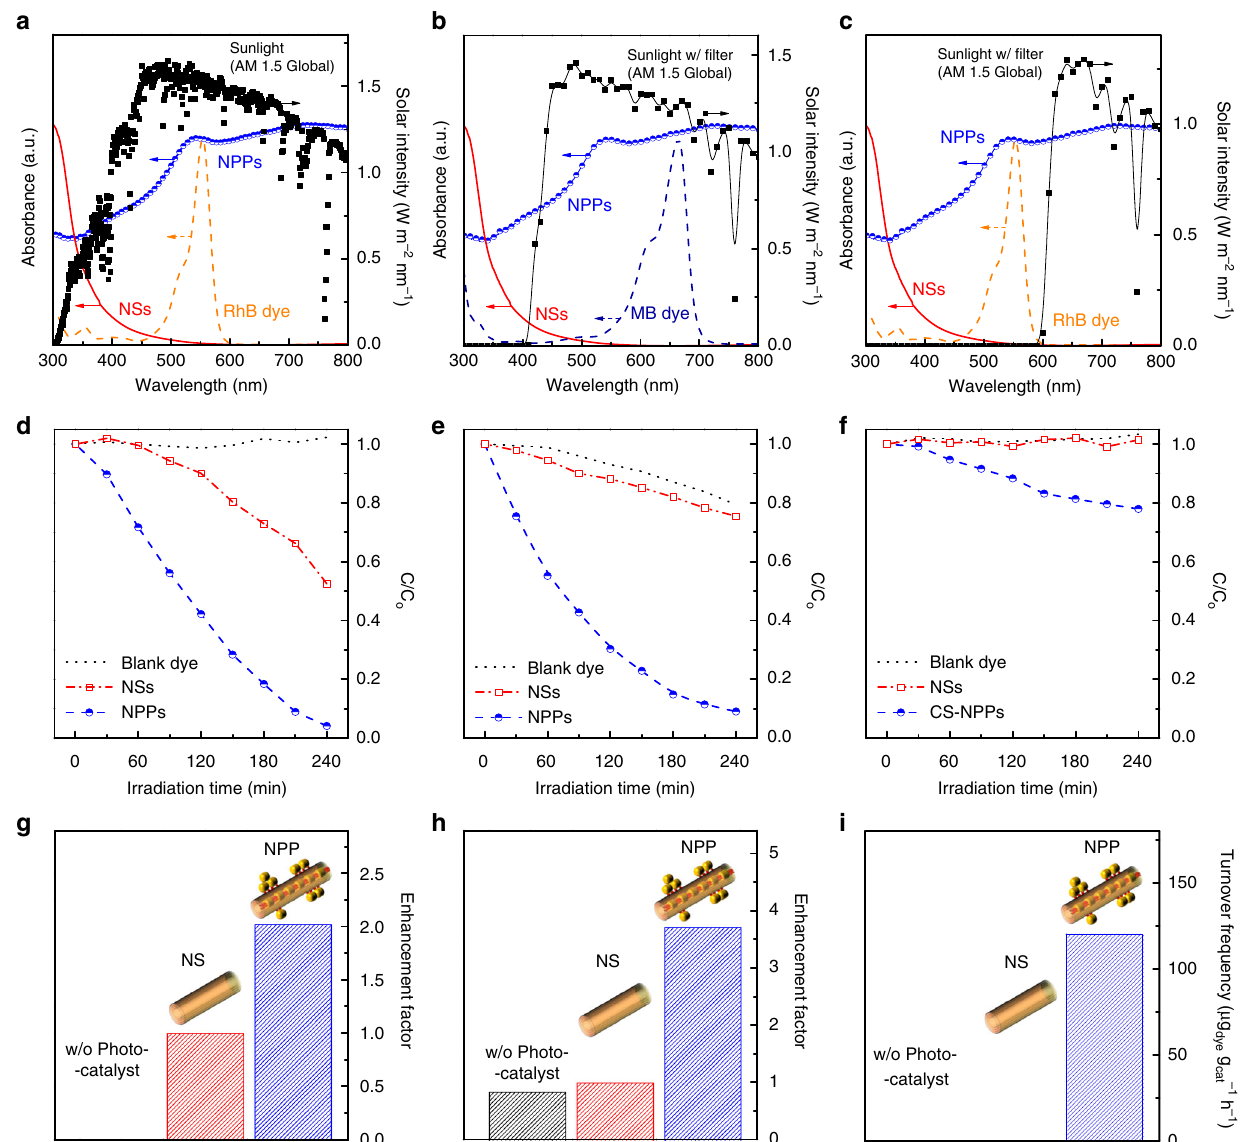
Fig. 3 Broadband photocatalytic activity of the Au@Nb@H x K 1 − x NbO 3 NPPs. a – c Spectra of simulated sunlight ( a ) further equipped with either an UV cutoff fi lter ( b ) or a colored glass fi lter ( c ) that work as irradiation sources for photocatalytic dye degradation. Absorption spectra of the employed H x K NSs (solid line) and the Au@Nb@H x K 1 − x NbO 3 NPPs (half- fi lled circles) as photocatalysts; methylene blue (MB) and rhodamine B (RhB) as probing species (dashed line) are plotted alongside for reference. d – f Photocatalytic decoloring of RhB ( d , f ), and MB ( e ) in the absence (dotted line) or in the presence of either niobate NSs (empty squares) or Au@Nb@H x K 1 − x NbO 3 NPPs (half- fi lled circles). g – i Comparison of the wavelength-dependent photoactivity between H x K 1 − x NbO 3 NSs and Au@Nb@H x K 1 − x NbO 3 NPPs under illumination with full solar light ( g ), visible-NIR integral light ( h ), and red-NIR integral light ( i ), respectively. Abbreviations used: MB, methylene blue; RhB, Rhodamine B; NSs, nanoscrolls; NPPs, nanopeapods; NIR,